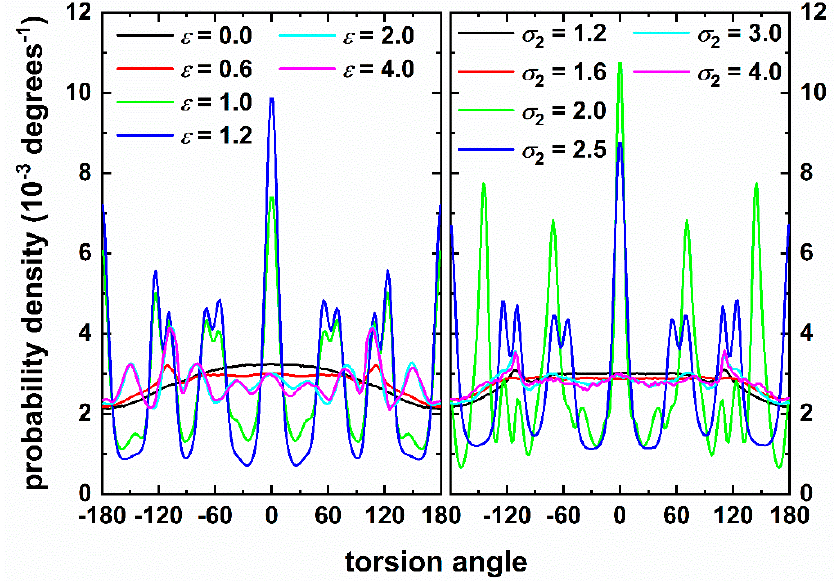
Figure 10. Torsion angle distribution as a function of ( left panel) attraction intensity for fixed range ( σ 2 = 1.2) and ( right panel): attraction range for fixed intensity ( ε = 0.5). Zero degrees correspond to trans conformation.